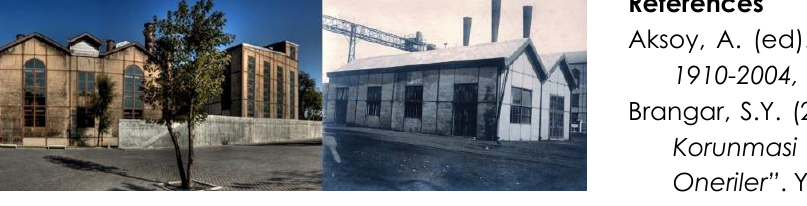
Figure 15. Adaptive reuse in Santralistanbul previous and new